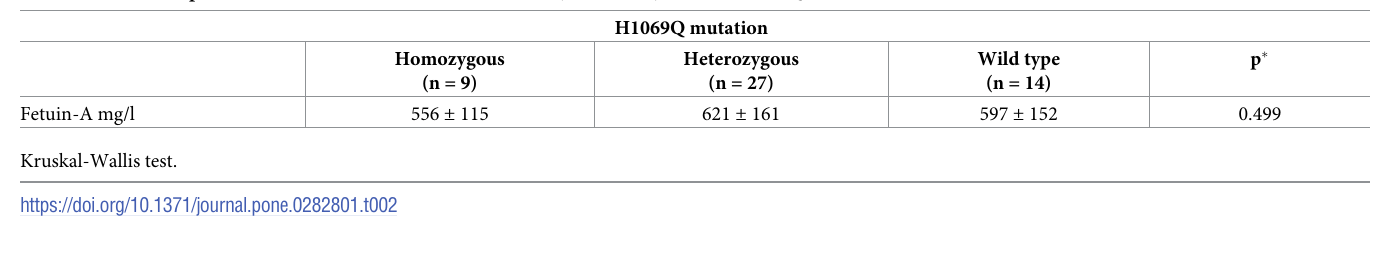
Table 2. Relationship between serum concentrations of fetuin-A (mean ± SD) and the H1069Q